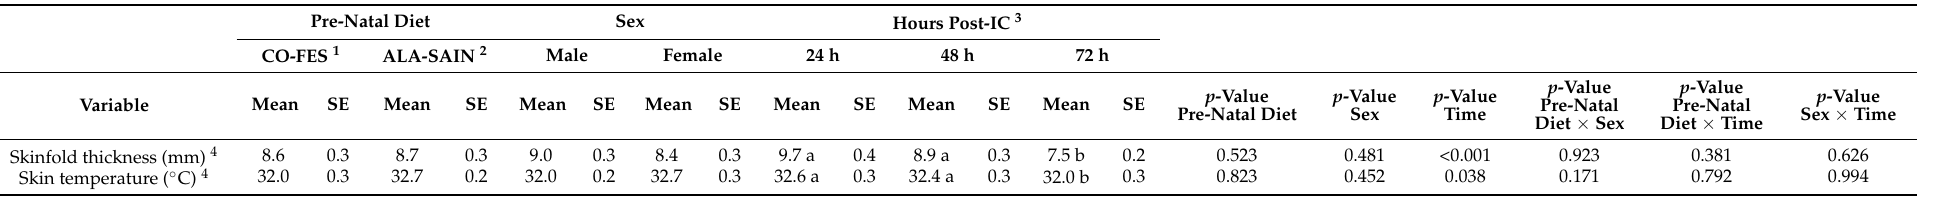
Table 6. Effects of pre-natal diet, lamb sex, time and their two-way interactions on lamb skinfold thickness and skin temperature after the inflammatory challenge post AHP. Pre-Natal Diet Sex Hours Post-IC 3 CO-FES 1 ALA-SAIN 2 Male Female 24 h